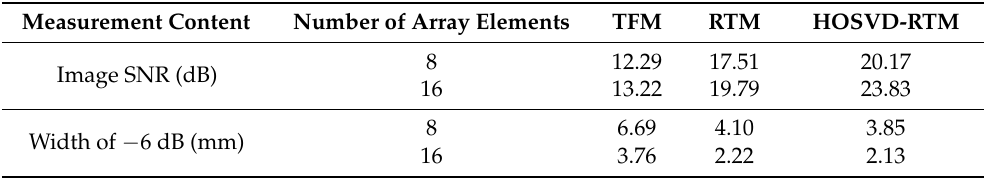
Table 1. Image SNR and width of − 6 dB in different imaging results.